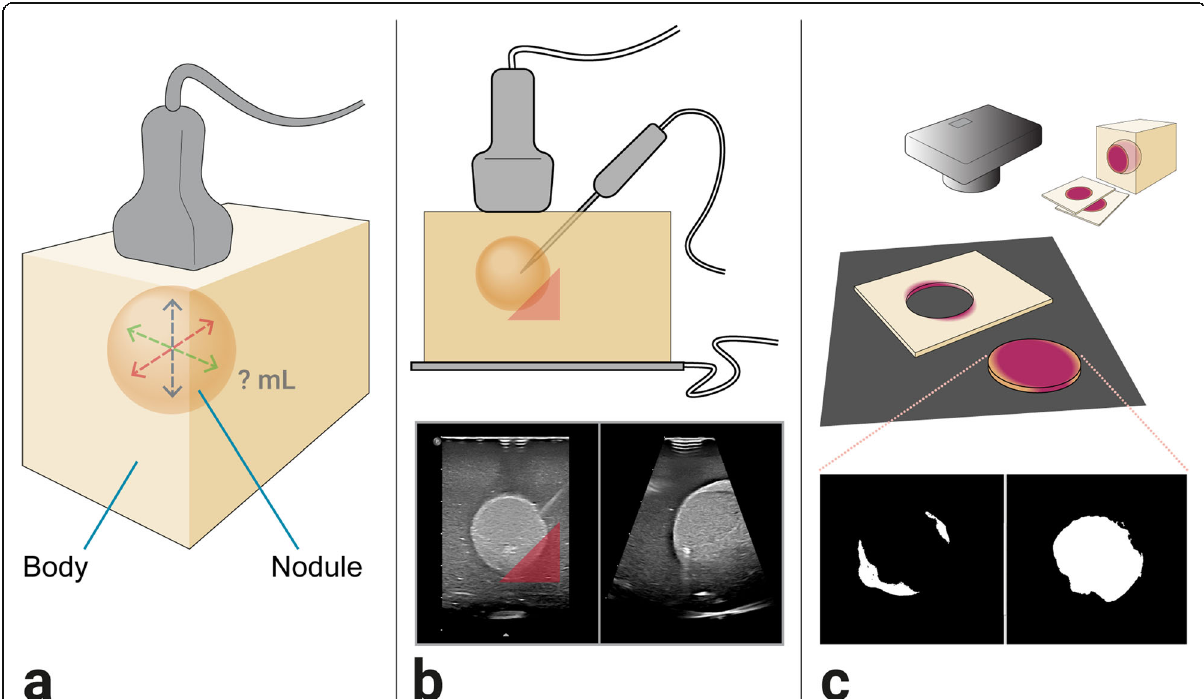
Fig. 1 Method depictions. a Three-dimensional (3D) view of the phantom with nodule volume in milliliter (mL) being estimated. b Side view of the ablation set-up with a grounding pad, radiofrequency ablation needle, and transducer and the red triangle indicating the danger triangle. Beneath that the 3D matrix (real-time 3D transducer) view of a nodule ablation. c Slicing, photographing, and pixel-based analysis of the body and nodule after ablation. 2D : Two-dimensional (conventional 2D transducer); 3D : Three-dimensional; 3D matrix Real-time 3D transducer; 3Dms : 3D mechanically swept